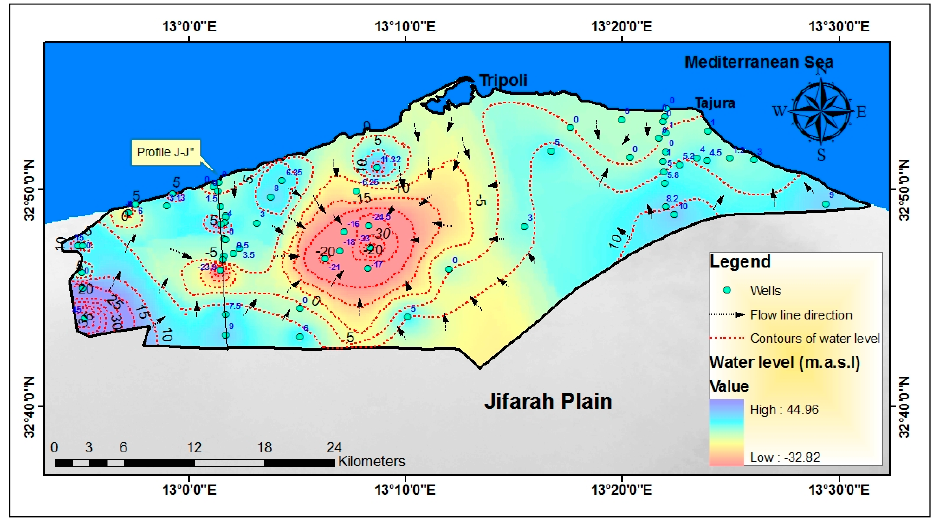
Figure 4. Tripoli piezometric map with flow vectors.